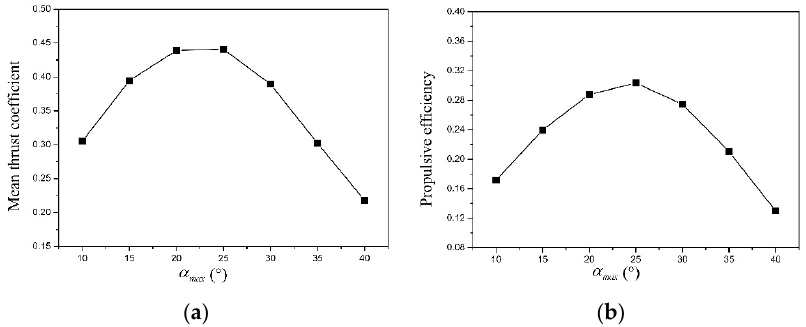
Figure 10. Performance curves: mean thrust coefficient versus versus angle of attack: ( a ) mean thrust coefficient; ( b ) propulsive efficiency.